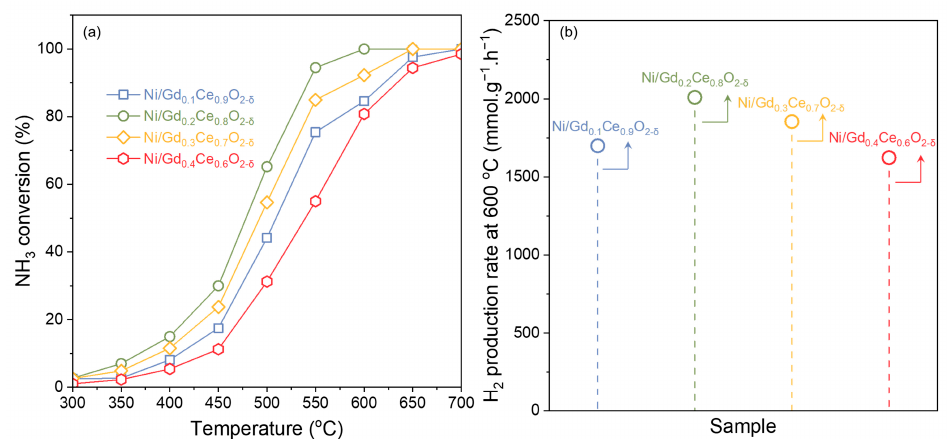
Figure 4. Ammonia decomposition performance over Ni/Gd x Ce 1-x O 2- δ catalysts. ( a ) Temperature- resolved ammonia conversion at 300 − 700 °C, and ( b ) the hydrogen production rate at 600 °C.